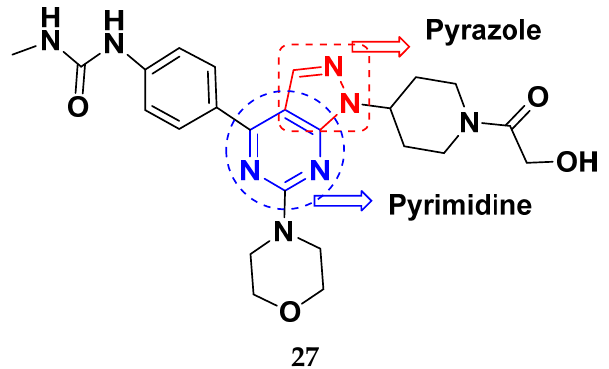
Figure 30. A Pyrimidine-pyrazole based hybrid ( 27 ). Dorsch et al. (2013) synthesized and patented pyrimidine-triazole based hybrids and evaluated their anticancer activity as general control non-derepressible 2 (GCN2) inhibitors of U20S human cells. Among the synthesized hybrids, the compound 28 (Figure 31) showed excellent activity with IC 50 ≤ 0.3 µ M [78].